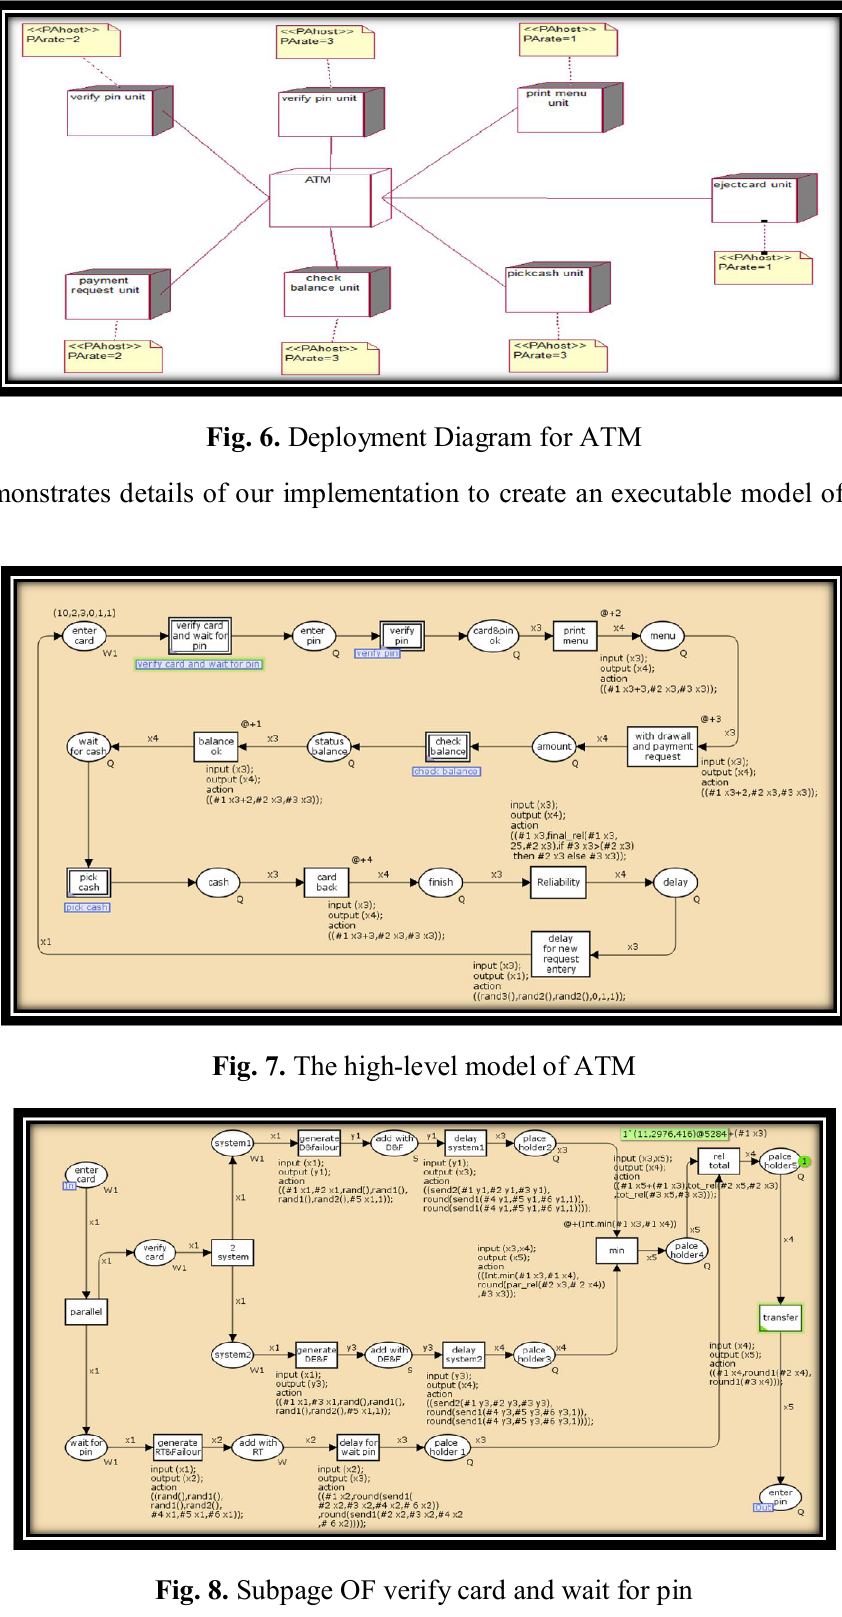
Fig. 8. Subpage OF verify card and wait for